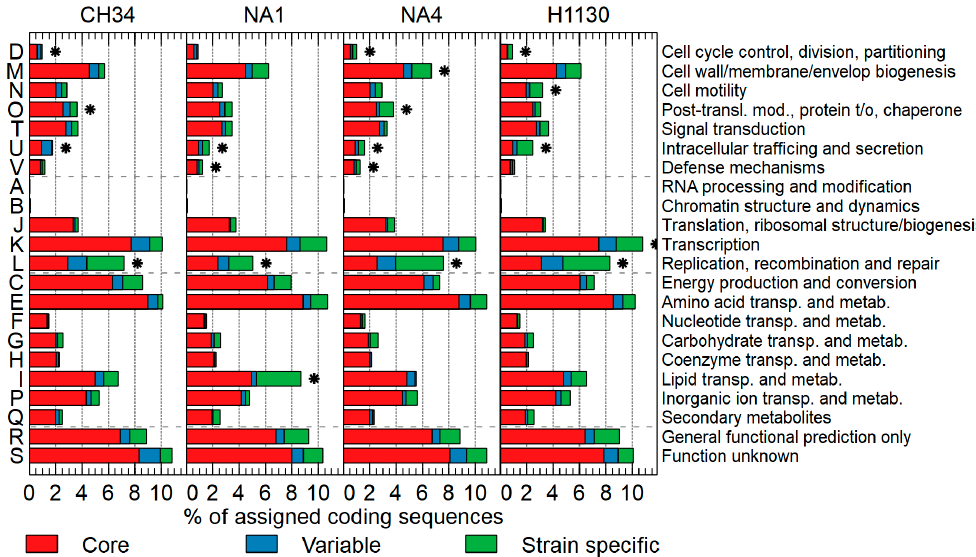
Figure 5. Percentage of CDSs assigned to a COG (clusters of orthologous groups) functional